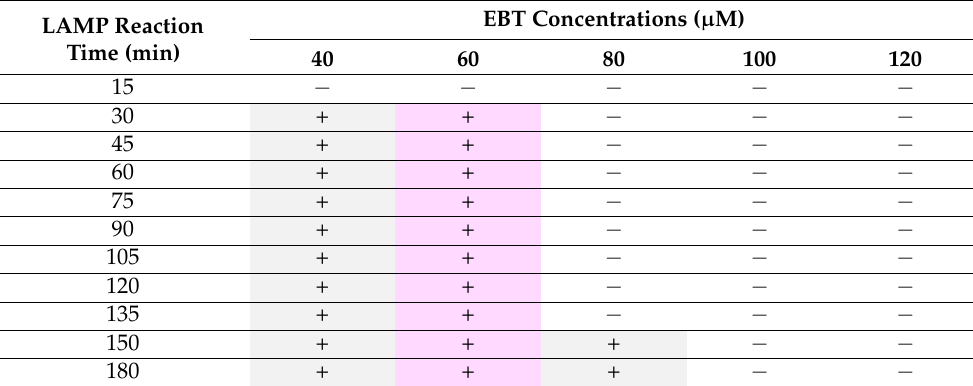
Note. The most distinct color change was observed at 60 µ M EBT between the positive and negative reactions after 30 min (pink-colored column). Although the reactions were positive at 40 and 80 µ M EBT, respectively, after 30 and 150 min, the color change between the positive and negative reactions were less distinctive at these concentrations (grey-colored column). +, positive LAMP reaction; − , negative LAMP reaction; EBT, eriochrome black